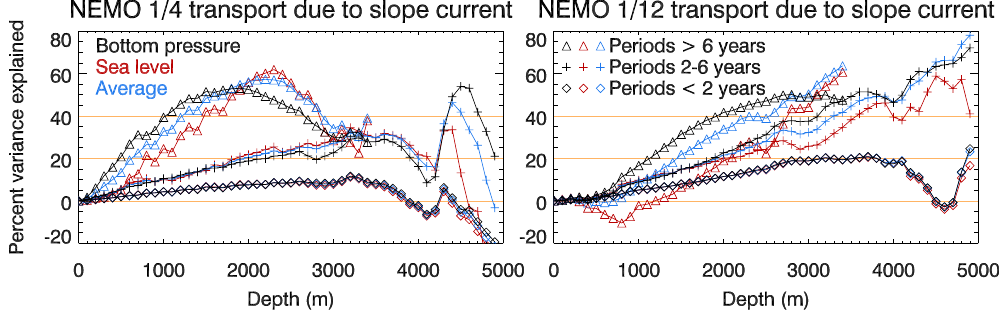
Fig. 6. Estimate of the percentage of total transport variance which is accounted for by flows on the continental slope, plotted as a function of the outermost depth contour to which the continental slope flow is integrated. The calculation is made for periods shorter than 2 years (diamonds), periods 2–6 years (pluses), and periods longer than 6 years (triangles). The currents are estimated by assuming they are barotropic flows associated with the circum-Antarctic average bottom pressure (black), sea level (red) or the average of the two (blue) along each depth contour. Left panel shows results from the 1 / 4 ◦ model, and right panel the 1 / 12 ◦ model.